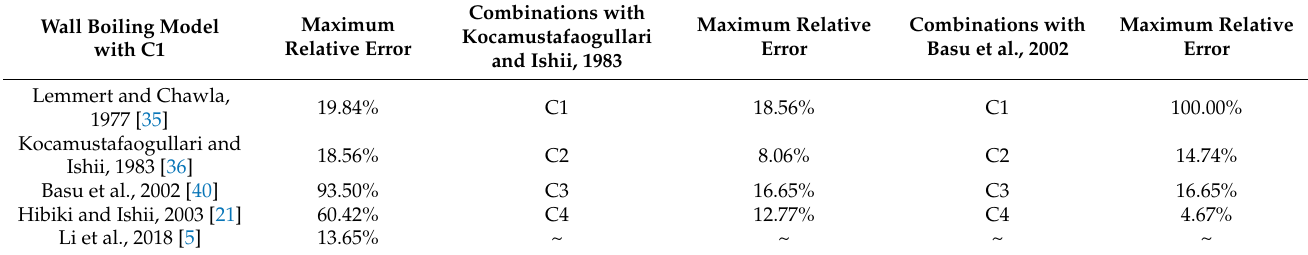
Table 10. Maximum relative errors between numerical results of j g with DEBORA-1 experiment data ( P = 2.62 MPa) for first loop of NPP ( P = 15.70